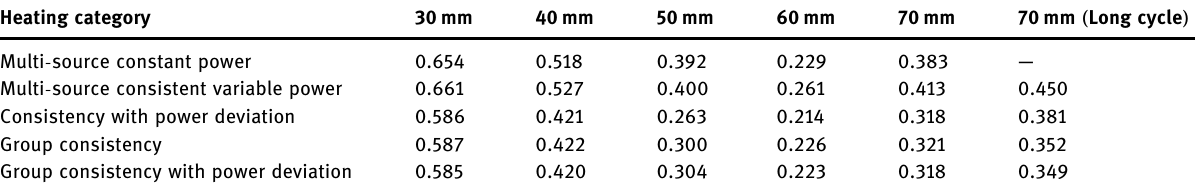
Table 8: COV on the upper surface of each heating model Heating category Multi - source constant power Multi - source consistent variable power Consistency with power deviation Group consistency